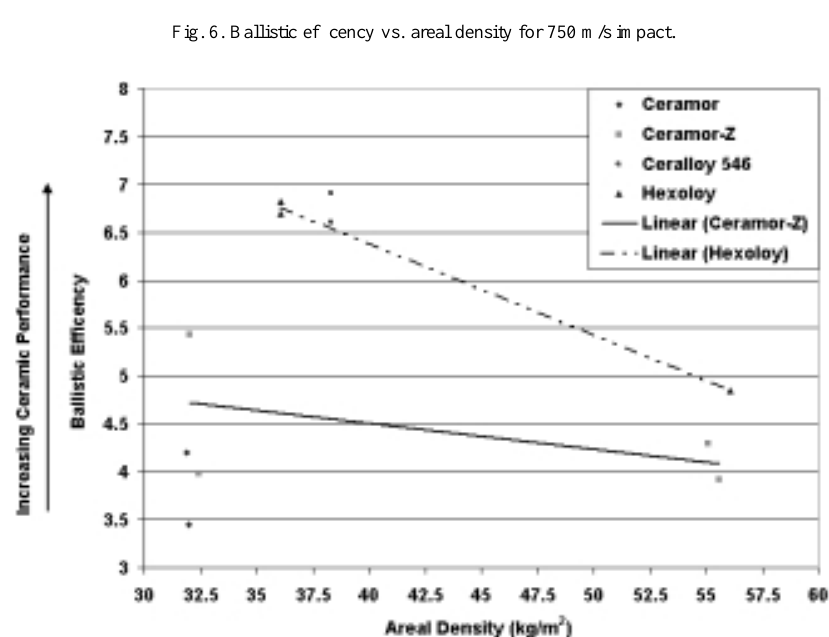
Fig. 7. Ballistic efficiency vs. areal density for 850 m/s